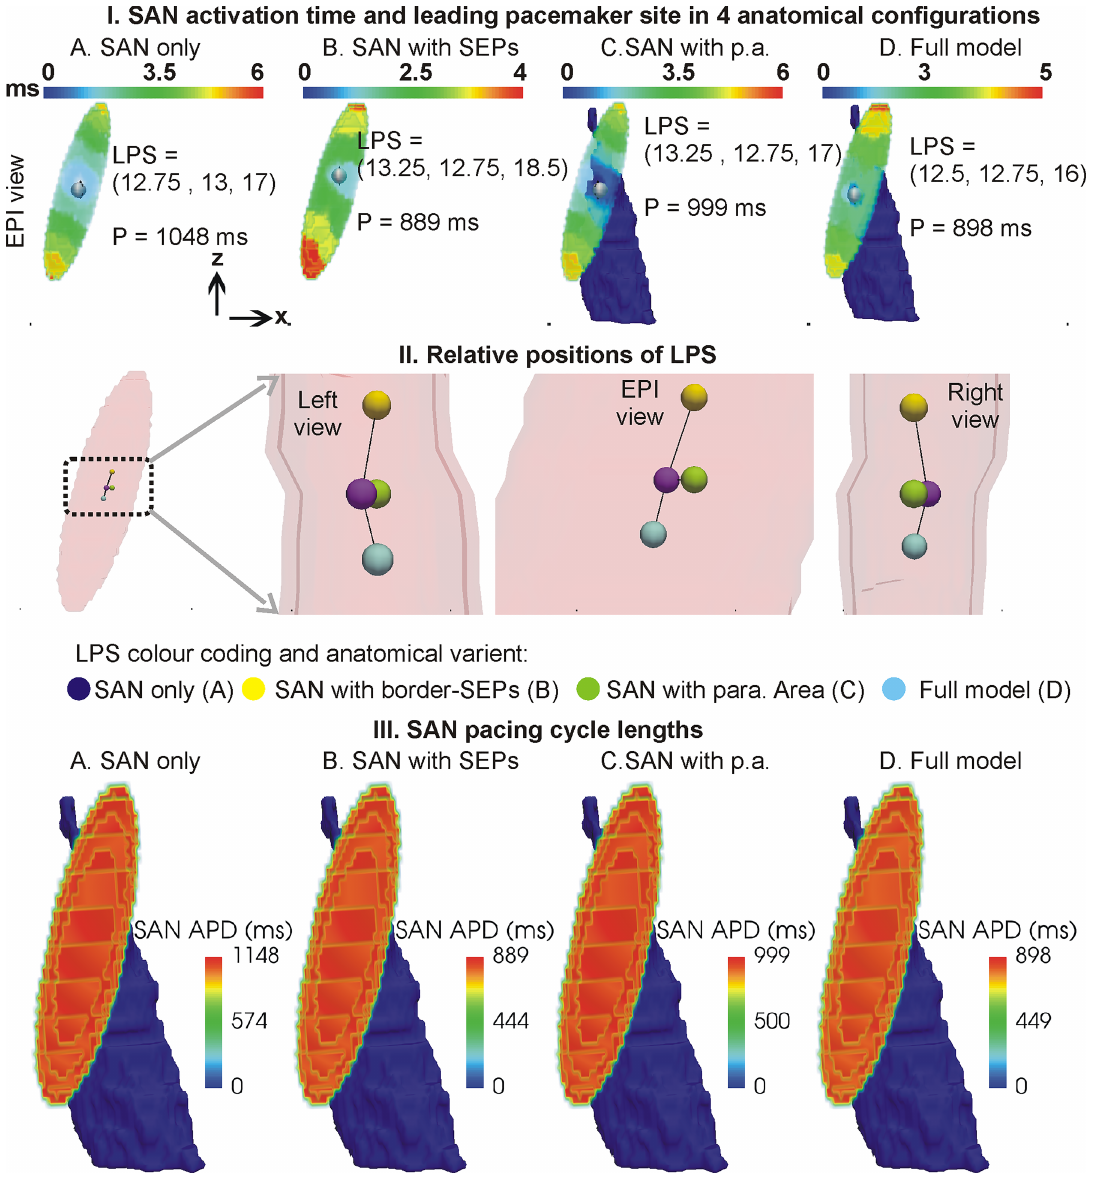
Fig 2. SAN activation times and leading pacemaker sites under basal conditions. I, A-D: Colour codedSAN activation times are shown in four cases. Leadingpacemaker site’s (white sphere within the SAN) coordinates and periodof atrial pacing,P, for each case are shown. Paranodalarea (blue in panels C and D) when present is shown. Atrial tissue (Fig 1) and atrial activationare omitted from the panelsfor clarity. II. Locationsof LPS in anatomicalvariants. The location of minimum diffusionwith the SAN is coincident with the SAN only LPS. III. Cycle lengths of individual SAN